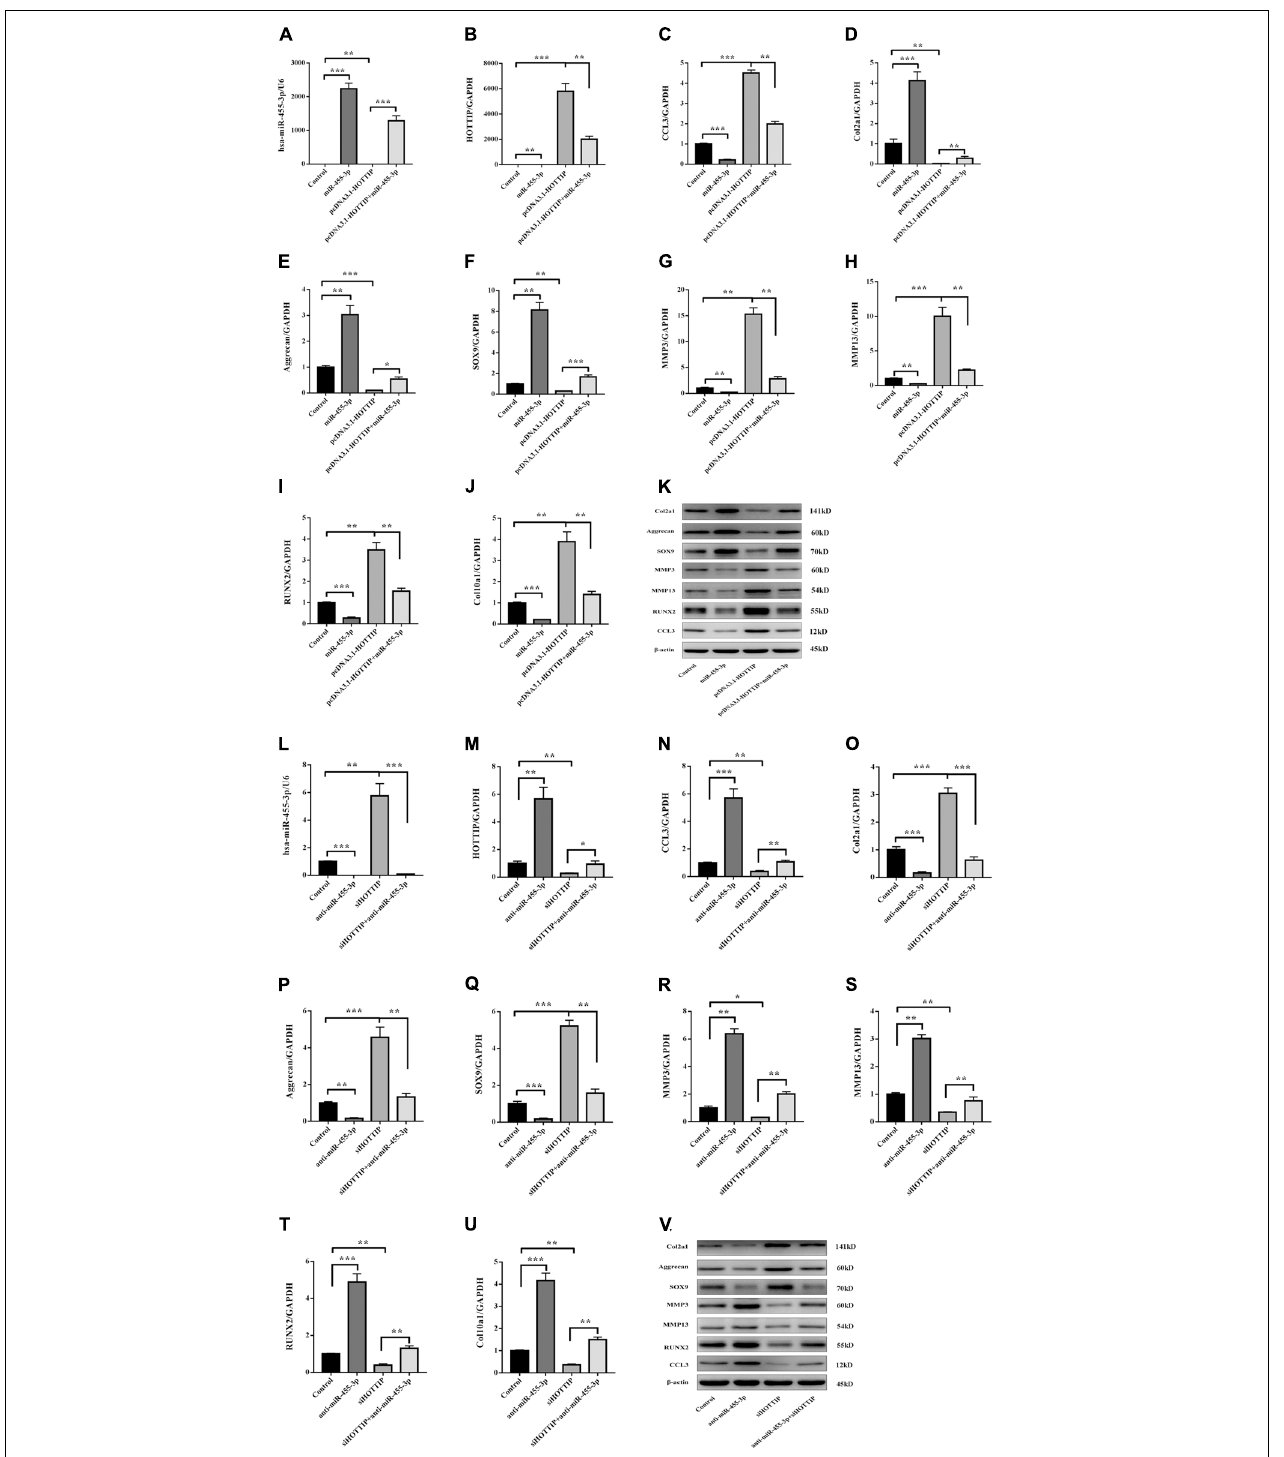
FIGURE 2 | miR-455-3p and HOTTIP regulate the expression of CCL3 and cartilage-specific gene during hMSCs chondrogenesis. hMSCs were transfected with miR-control, miR-455-3p, pcDNA3.1-HOTTIP, pcDNA3.1-HOTTIP + miR-455-3p, anti-miR-control, anti-miR-455-3p, siHOTTIP, siHOTTIP + anti-miR-455-3p, respectively, and then induced to differentiate into chondrocytes for 14 days. The expression level of miR-455-3p (A,L) and HOTTIP (B,M) were estimated by RT-qPCR, while the expression levels of CCL3 (C,K,N,V) and Col2a1 (D,K,O,V) , Aggrecan (E,K,P,V) , SOX9 (F,K,Q,V) , MMP3 (G,K,R,V) , MMP13 (H,K,S,V) , RUNX2 (I,K,T,V), and COL10A1 (J,K,U,V) were estimated by RT-qPCR and western blotting. GAPDH and β -actin were used as endogenous controls. The data shown represent the mean ± SD of three independent experiments performed with samples from three different donors. ∗ p < 0.05, ∗∗ p < 0.01, ∗∗∗ p < 0.001.